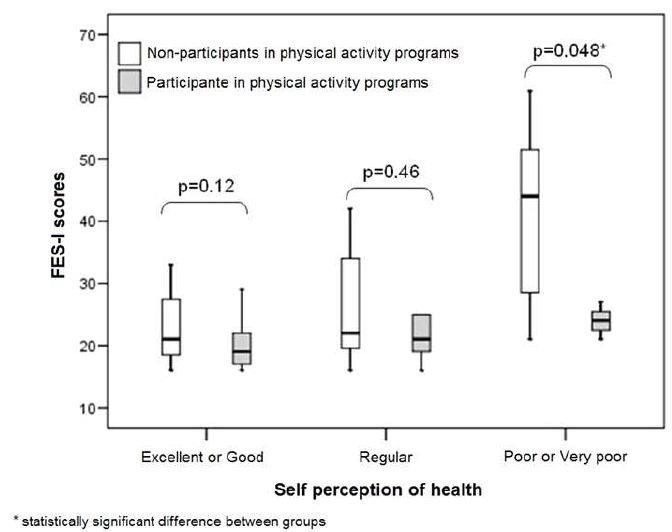
Figure 2. Differences between-groups in the FES-I scores relative to perceived health